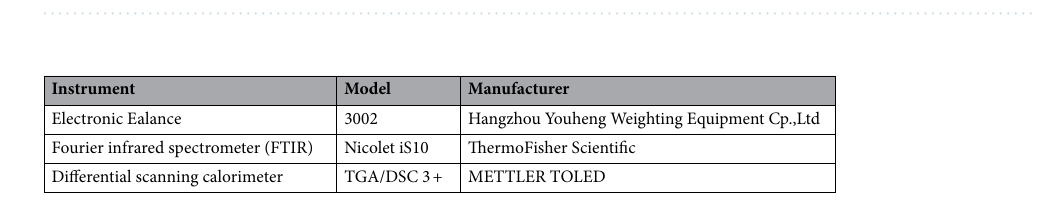
Table 1. List of experimental reagents.